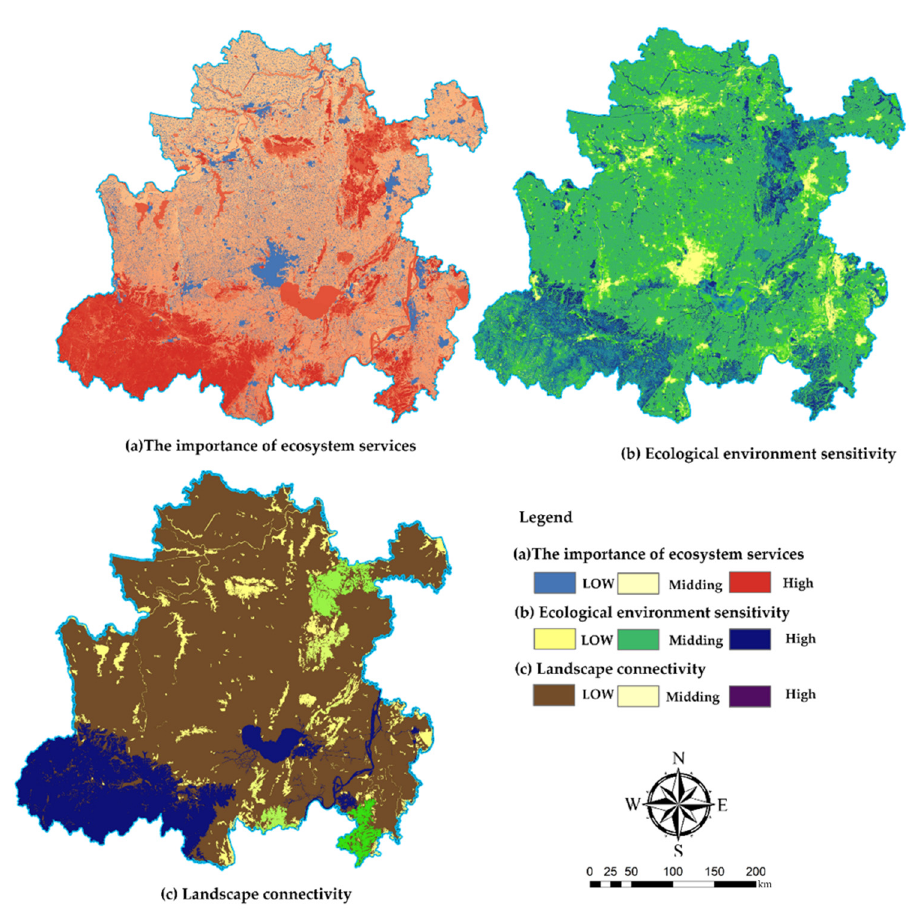
Figure 4. The spatial pattern of the importance of ecosystem services, ecological sensitivity, and landscape connectivity in the Hefei metropolitan area.